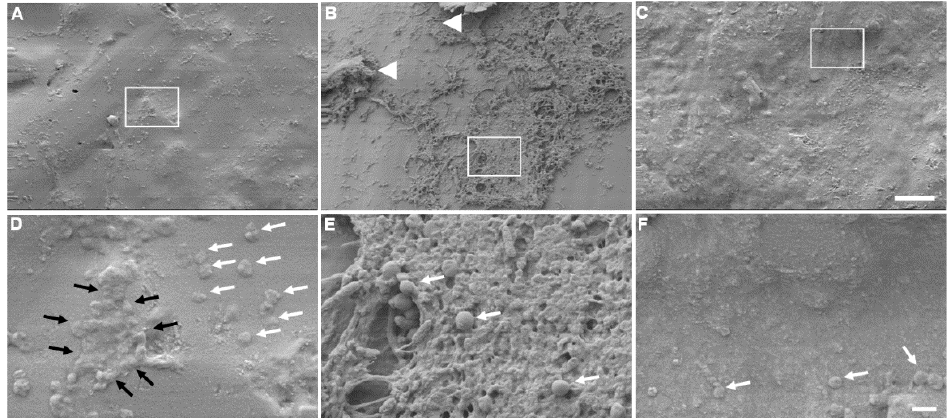
Figure 5. Biofilm formation. Surface morphology of the three types of experimental occluders (seven days in the presence of S. aureus ) were imaged using SEM. ( A , D ) Delta R ; ( B , E ) Odyssey R ; ( C , F ) Alphamed R . Arrow heads indicate extensive three-dimensional (3D) biofilm formation observed with the Odyssey R occluder. White arrows indicate the presence of individual S. aureus cells. Black arrows indicate the presence of a small biofilm present on the surface of the Delta R occluder. White boxes in A, B, and C are areas magnified and shown in D, E, and F, respectively. Scale bar for A, B, C = 100 µ m; Scale bar for D, E, F = 1 µ